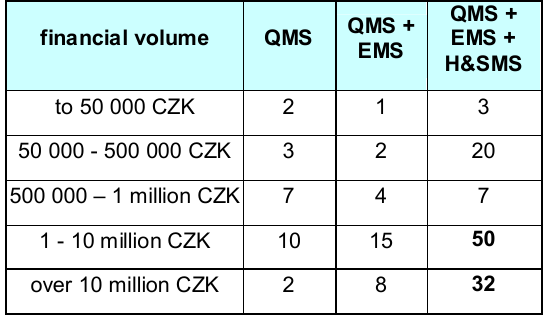
Table 1 - Dependence of the contracts financial volume on the specific SM requirements in the period